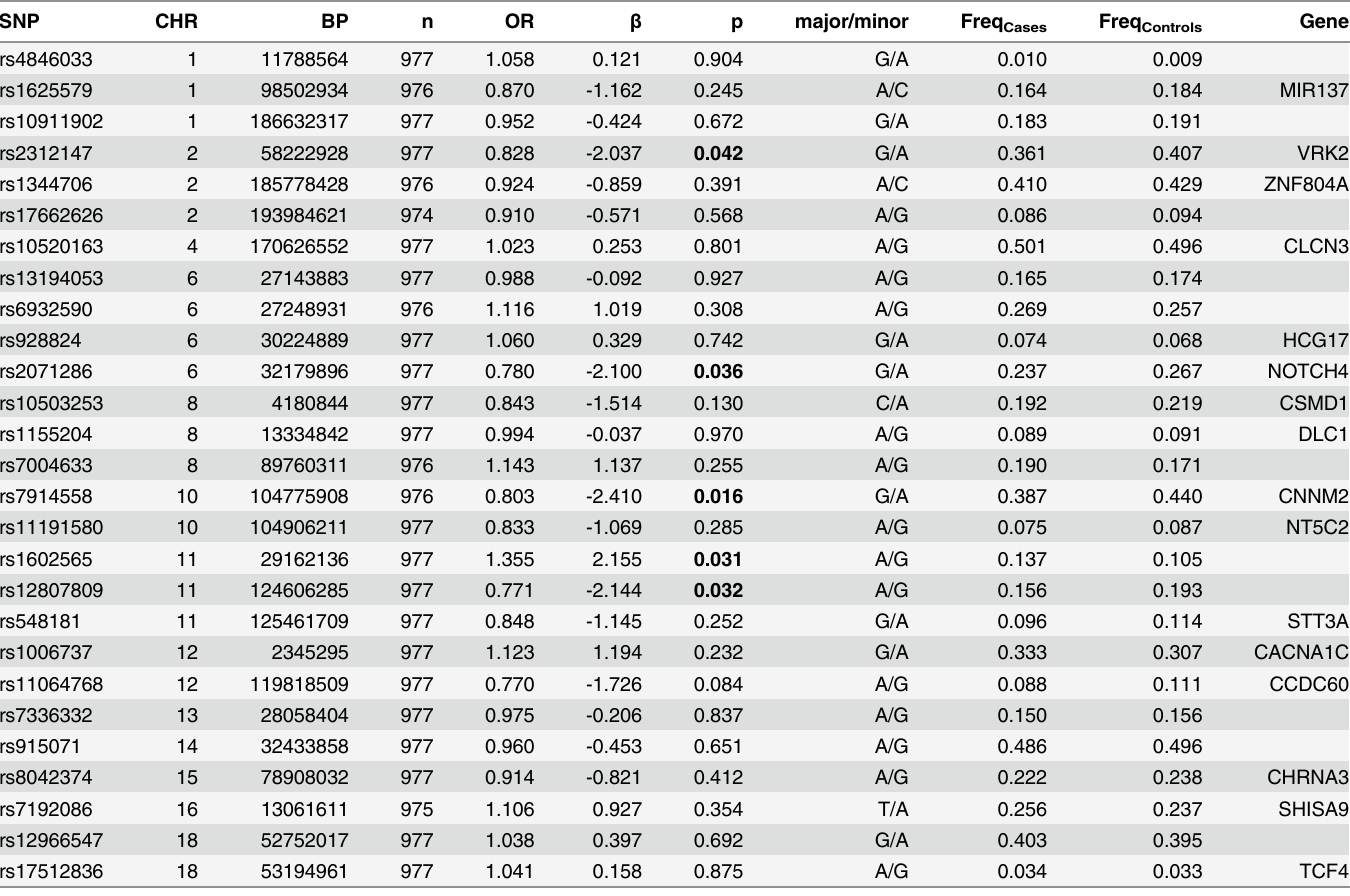
Table 2. Replication of previously reported autosomal SNPs associated with schizophrenia in GWAS studies.[9 – 22]. p-values were obtained using logistic regression with the first 3 principal components as covariates.